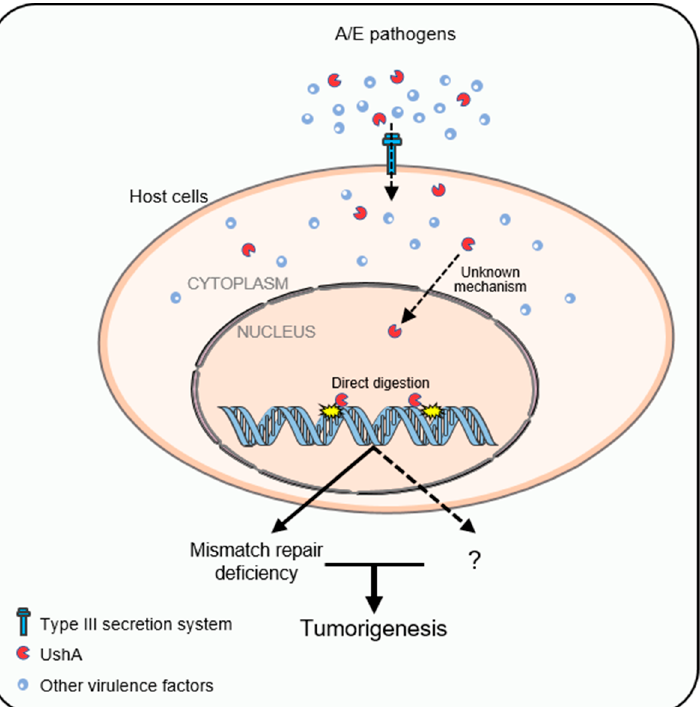
Figure 4. The novel genotoxin UshA and its role in tumorigenesis. A/E pathogens inject multiple virulence factors, including UshA, into host cells via the type III secretion system after colonization. The novel genotoxin UshA digests chromosomal DNA and results in unique mutational signatures in host cells, which is associated with DNA mismatch repair de fi ciency and tumorigenesis of CRC.